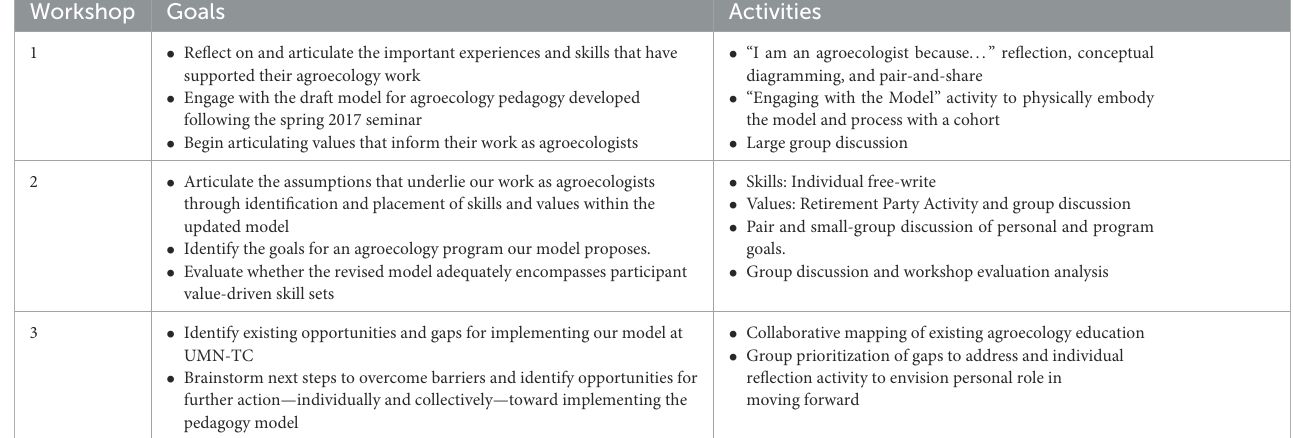
TABLE 2 Overview of goals and activities for the “developing a model of agroecology training for graduate students” workshop series.